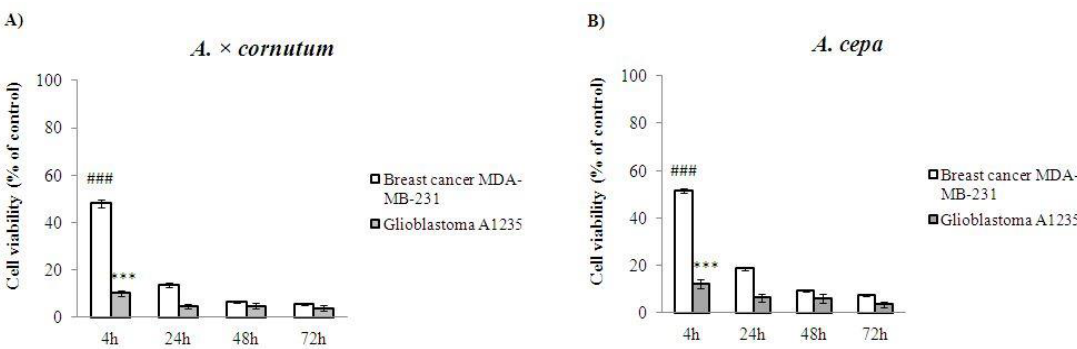
Figure 4. Cytotoxic effect of A. × cornutum and A. cepa methanolic extracts at concentration of 100 µ g/mL on two human cancer cell lines: breast and glioblastoma cancer cells. The antiproliferative effect of A. × cornutum ( A ) and A. cepa ( B ) after 4, 24, 48 and 72 h of exposure. The percentage of metabolically active cells is expressed in comparison to the untreated control. The results are presented as a mean value ± SD of the three independent experiments. The statistically significant difference of glioblastoma cell line is represented as *** p < 0.001 for A. × cornutum and A. cepa , and the statistically significant difference of breast cancer cell line is represented as ### p < 0.001 for A. × cornutum and A. cepa .